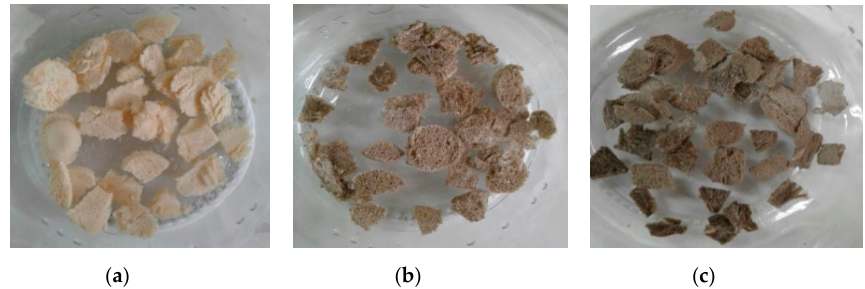
Figure 4. Pictures of the freeze-dried scaffolds of chitosan (CS) ( a ) without graphene oxide (GO), ( b ) with 0.5% of GO and ( c ) with 1.0% of